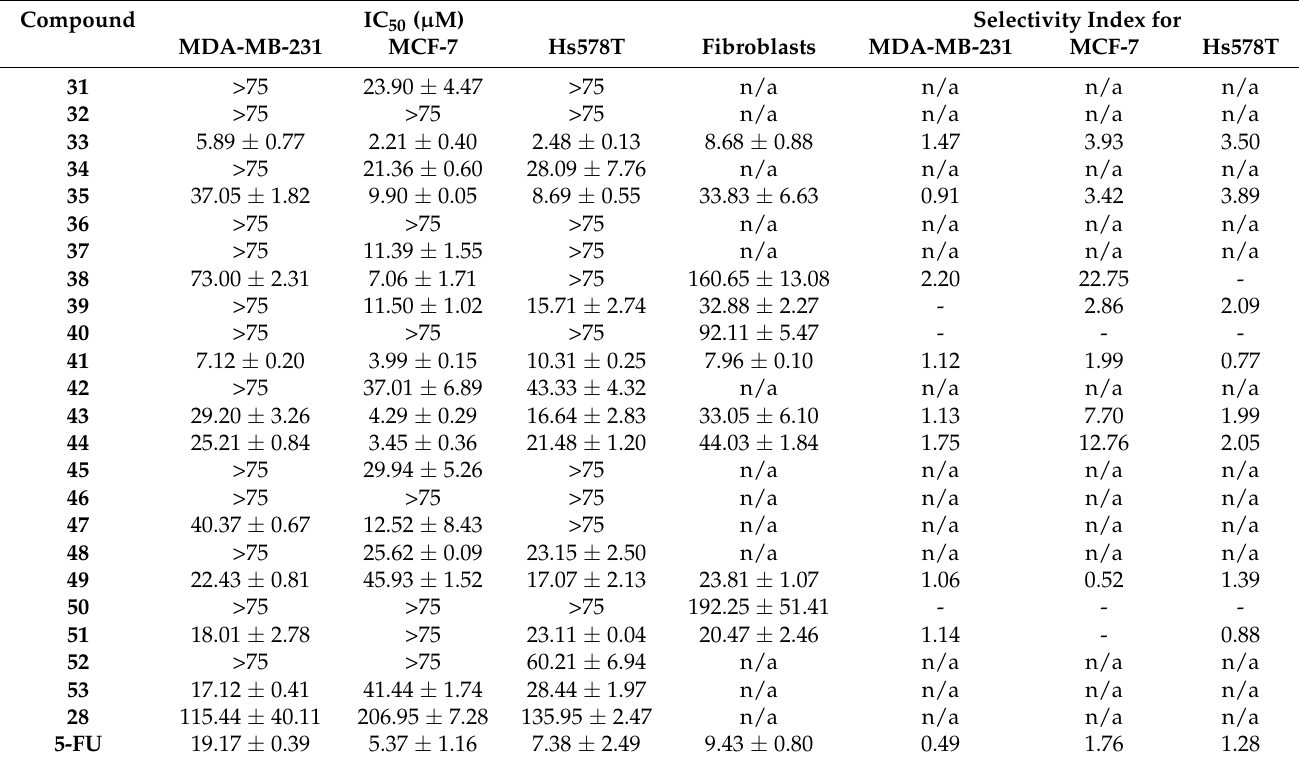
Table 1. Antiproliferation activity of synthesized compounds 32 – 54 in the MDA-MB-231, MCF-7 and Hs578T breast cancer cell lines as well as against normal human fibroblast cell line. Selectivity index values are also provided for each IC 50